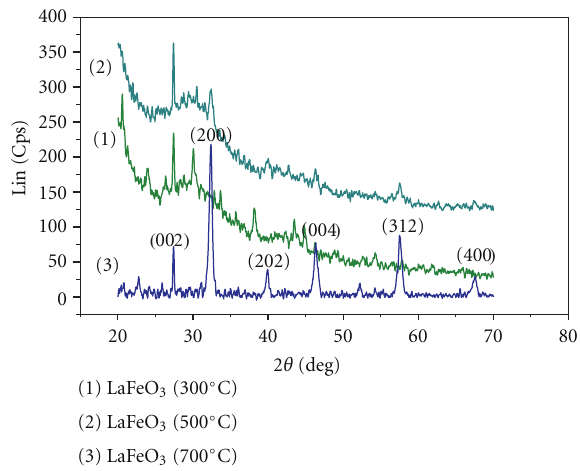
Figure 4: The powder X-ray di ff raction patterns of gel complex heated at 300 ◦ C (line 1); 500 ◦ C (line 2); 700 ◦ C (line 3) for 3 hours.